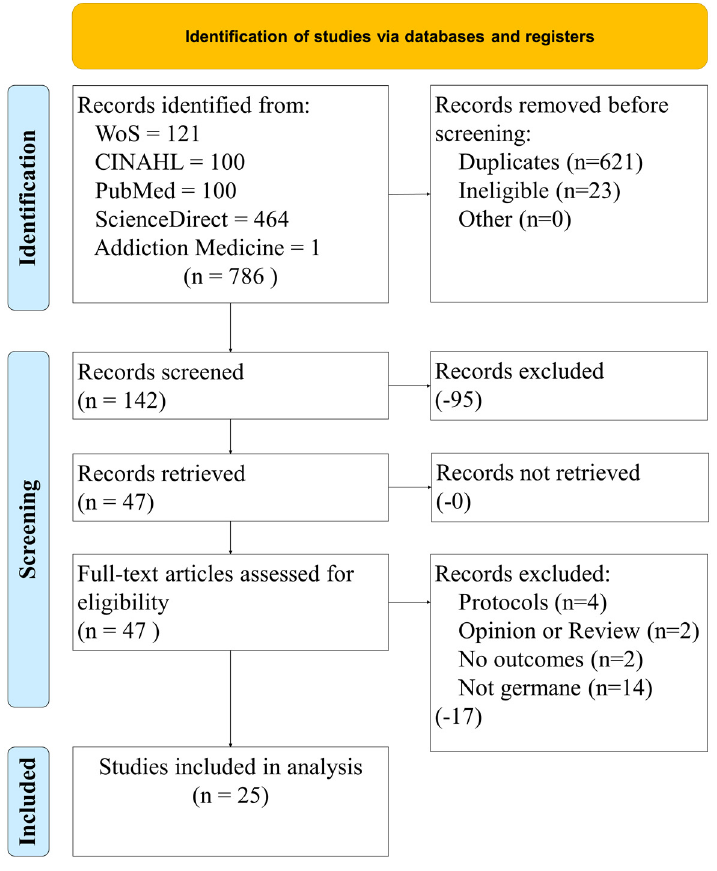
Figure 1. Study selection process.